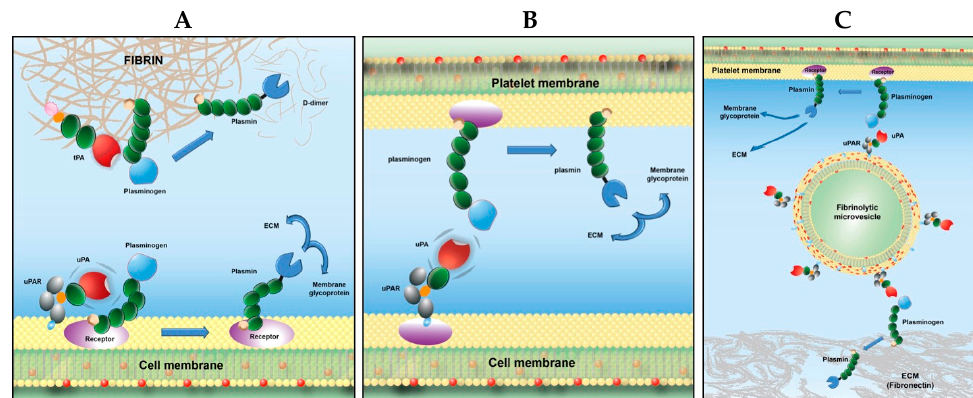
Figure 6. Schematic representation of plasmin formation on biological surfaces [90]. ( A ) Canonical mechanism for plasminogen activation; assemblage of both plasminogen and its activator on the same surface is required for plasmin generation. ( B ) Fibrinolytic cross-talk mechanism on platelets: platelet-bound plasminogen is activated by uPA-bearing cells (e.g., monocytes). ( C ) Fibrinolysis cross-talk mechanism by microvesicles: ECM- or platelet-bound plasminogen is transformed into plasmin by microvesicles bearing uPA.